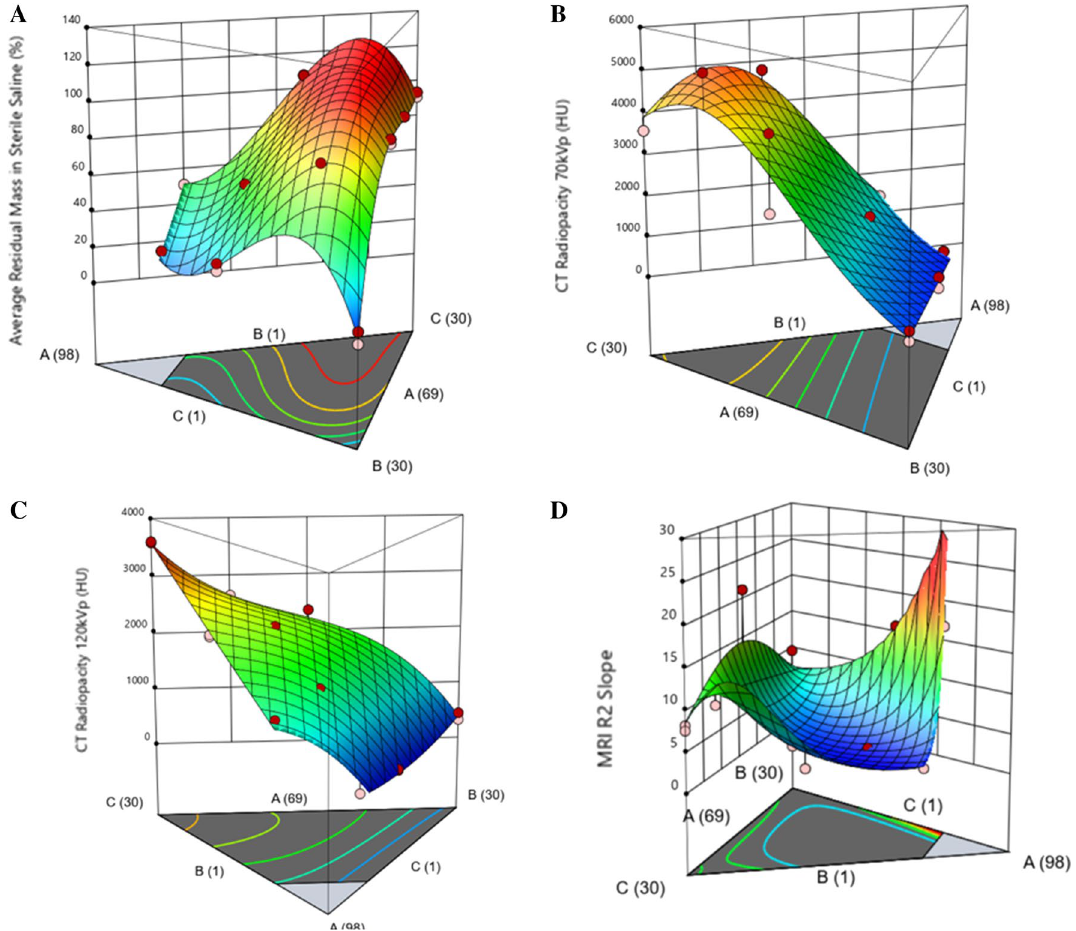
Fig. 1 Contour plots of responses for A average residual mass at 2 h in sterile saline, B radiopacity at 70 kVp. C CT radiopacity at 120 kVp, and D MRI R2 slope. The x-axes are labelled as ‘A’: mol% B